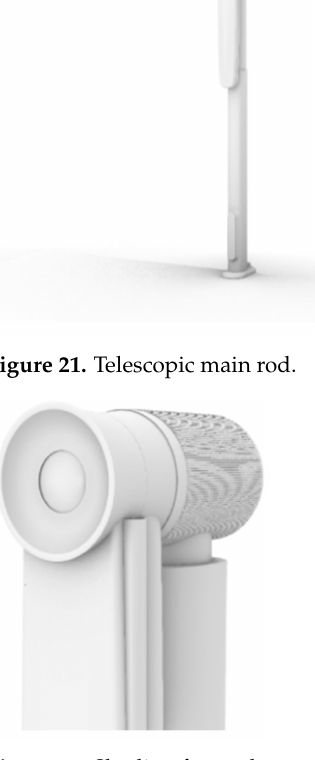
Figure 22. Shading fan and movable component.